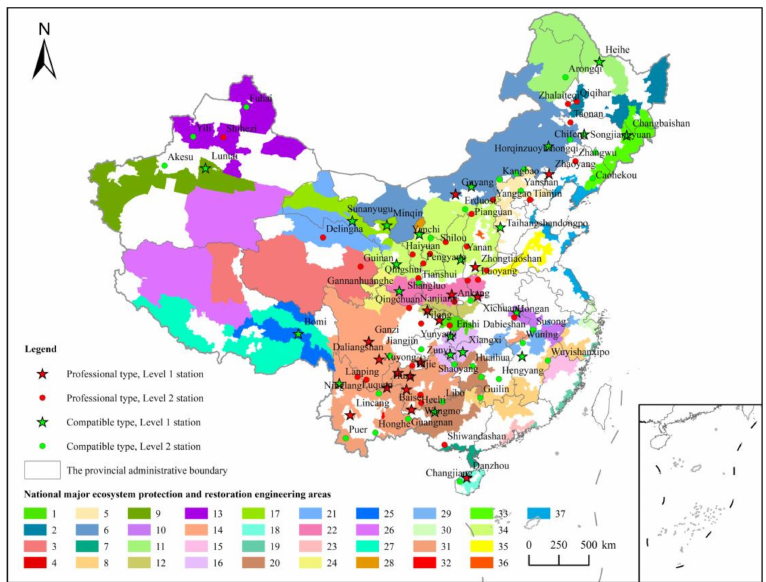
Figure 4. The layout of monitoring stations in national major ecosystem protection and restoration engineering areas(NMEPREA) (Numbers 1 to 37 represent NMPREA).